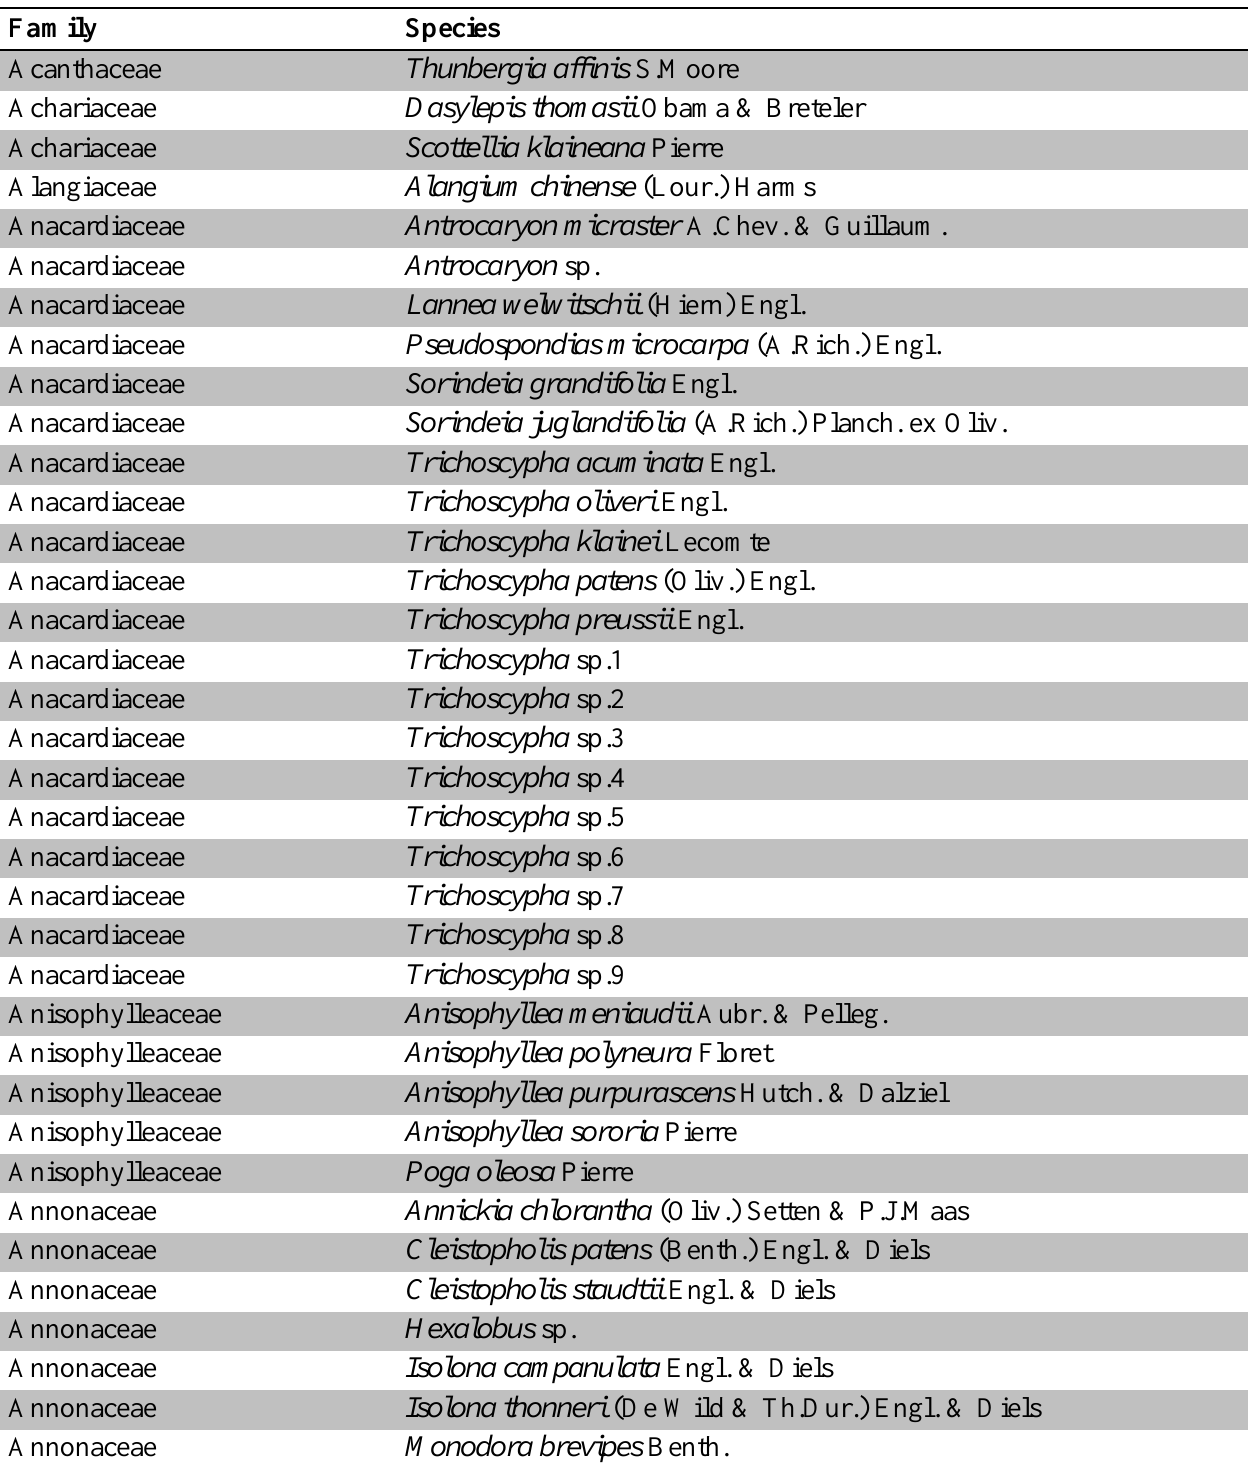
TABLE 1-A1: Species occurrence in the different forest types in the Rumpi Hills Forest Reserve,